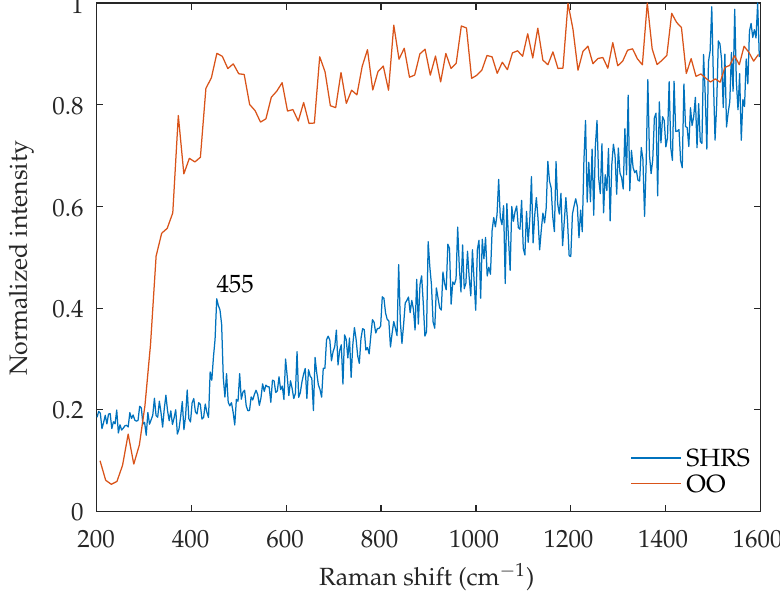
Figure 12. Raman spectrum of quartz (SiO 2 ), obtained from the copper ore. The obtained SNR from both SHRS and dispersive spectrometer for the band at 455 cm − 1 were approximately